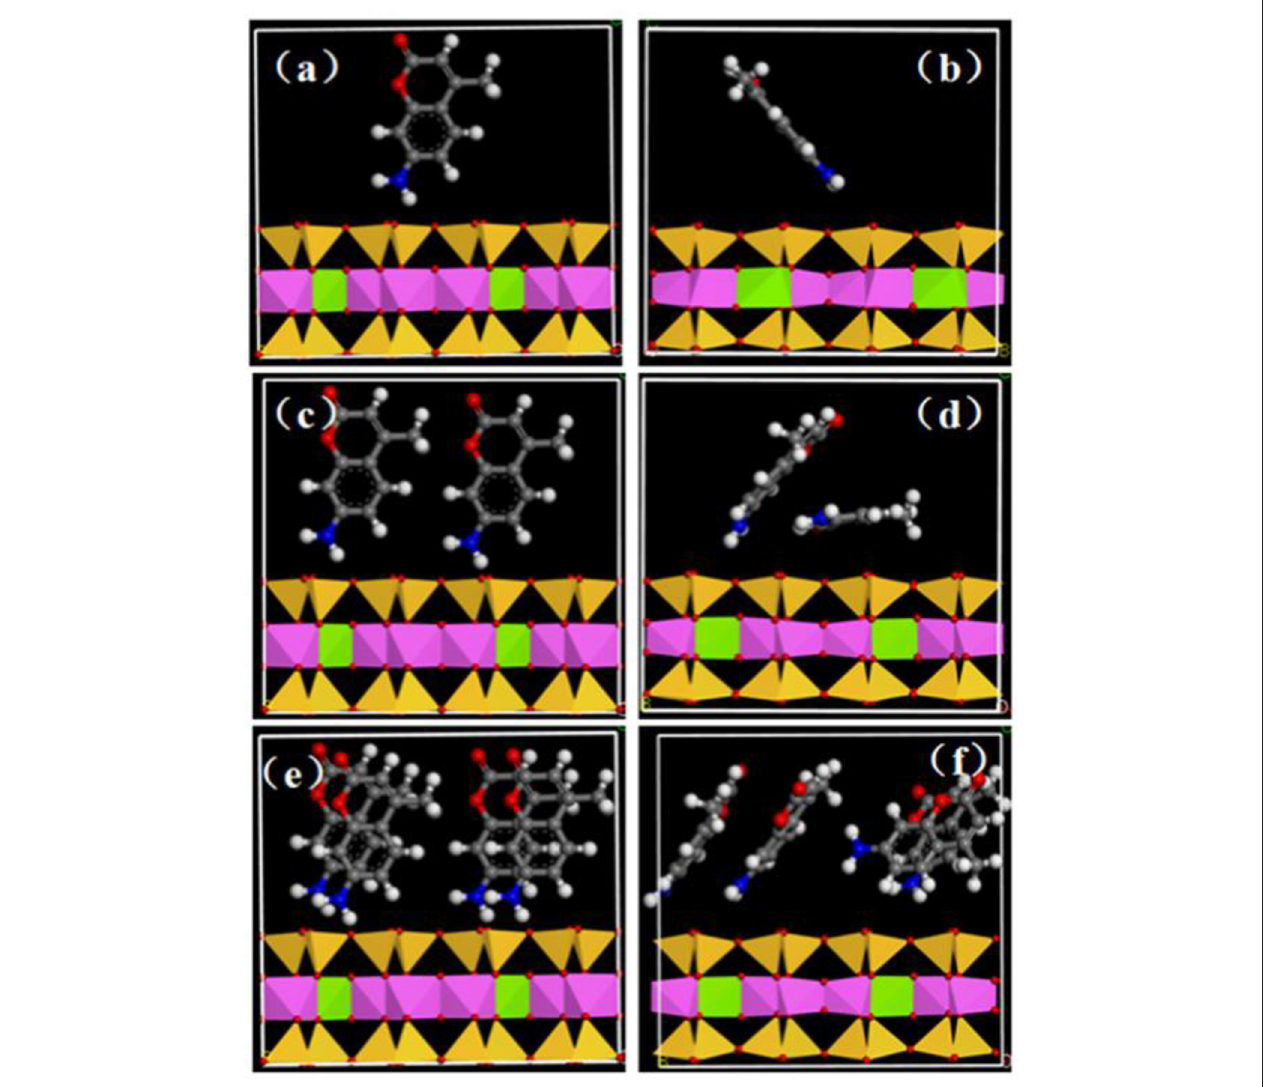
FIGURE 7 | Dynamic simulation of molecular interposition AMC into MMT at a different angle on account of the electric density and AMC loading distinction. The initial states were represented by a, c , and e ; and b, d , and f represent the states after simulation: a stands for low concentration, c stands for medium concentration and e stands for higher concentration. The all strains, Mg, green; Al, pink; Si, yellow; C, gray; N, blue; O, red; H, white.